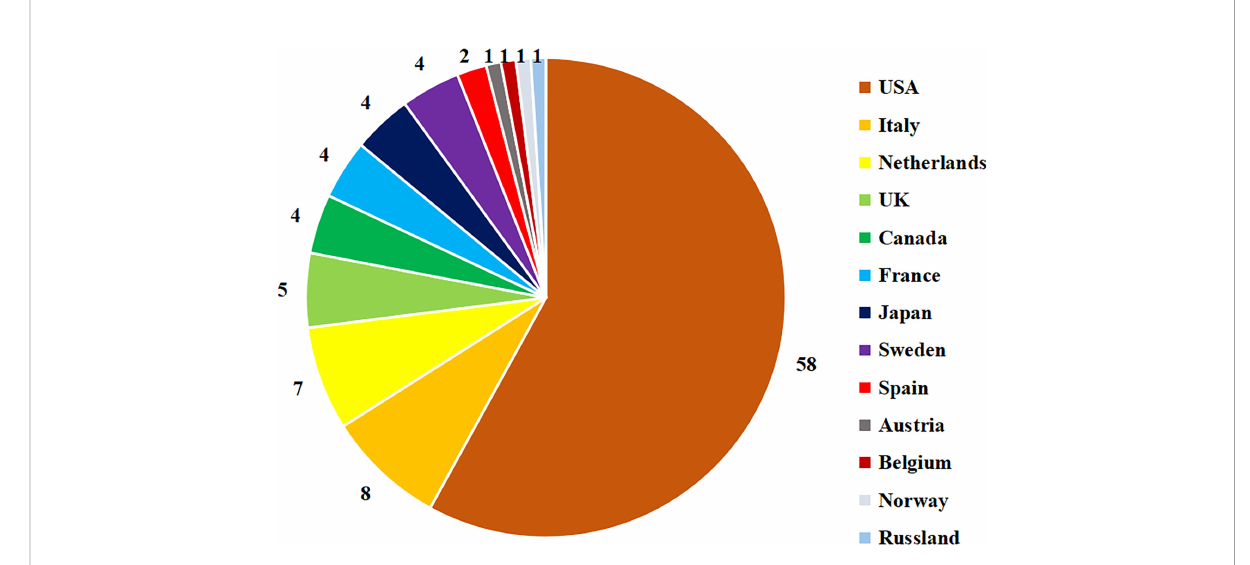
FIGURE 3 The distribution of countries associated with the top 100 most cited